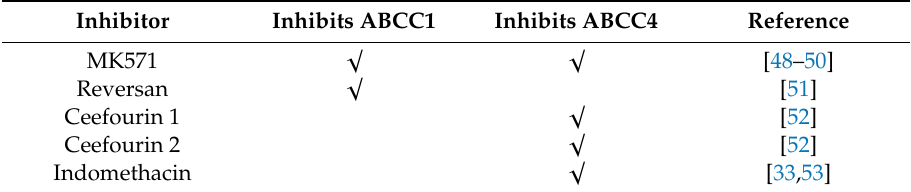
Table 1. ABCC inhibitors used in this study.